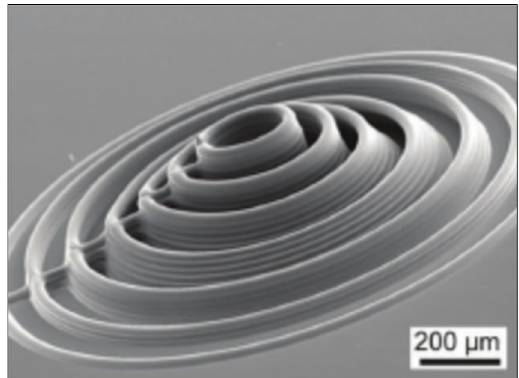
Figure 36 . A metallic circular microstructure made using DIW with highly concentrated silver nanoparticle ink. The structure was fabricated layer-by-layer with continuous ink deposition and has a minimum feature size of 2 μ m. Here, the scale bar is 200 μ m. (Reprinted from [155], with the permission of John Wiley & Sons Inc.).